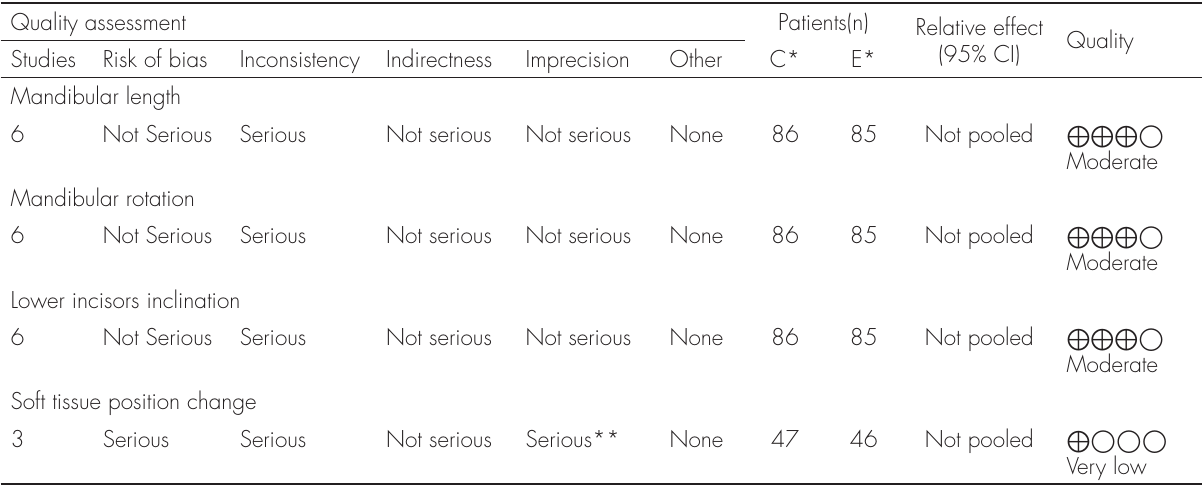
Table VI. GRADE assessment for quality of available